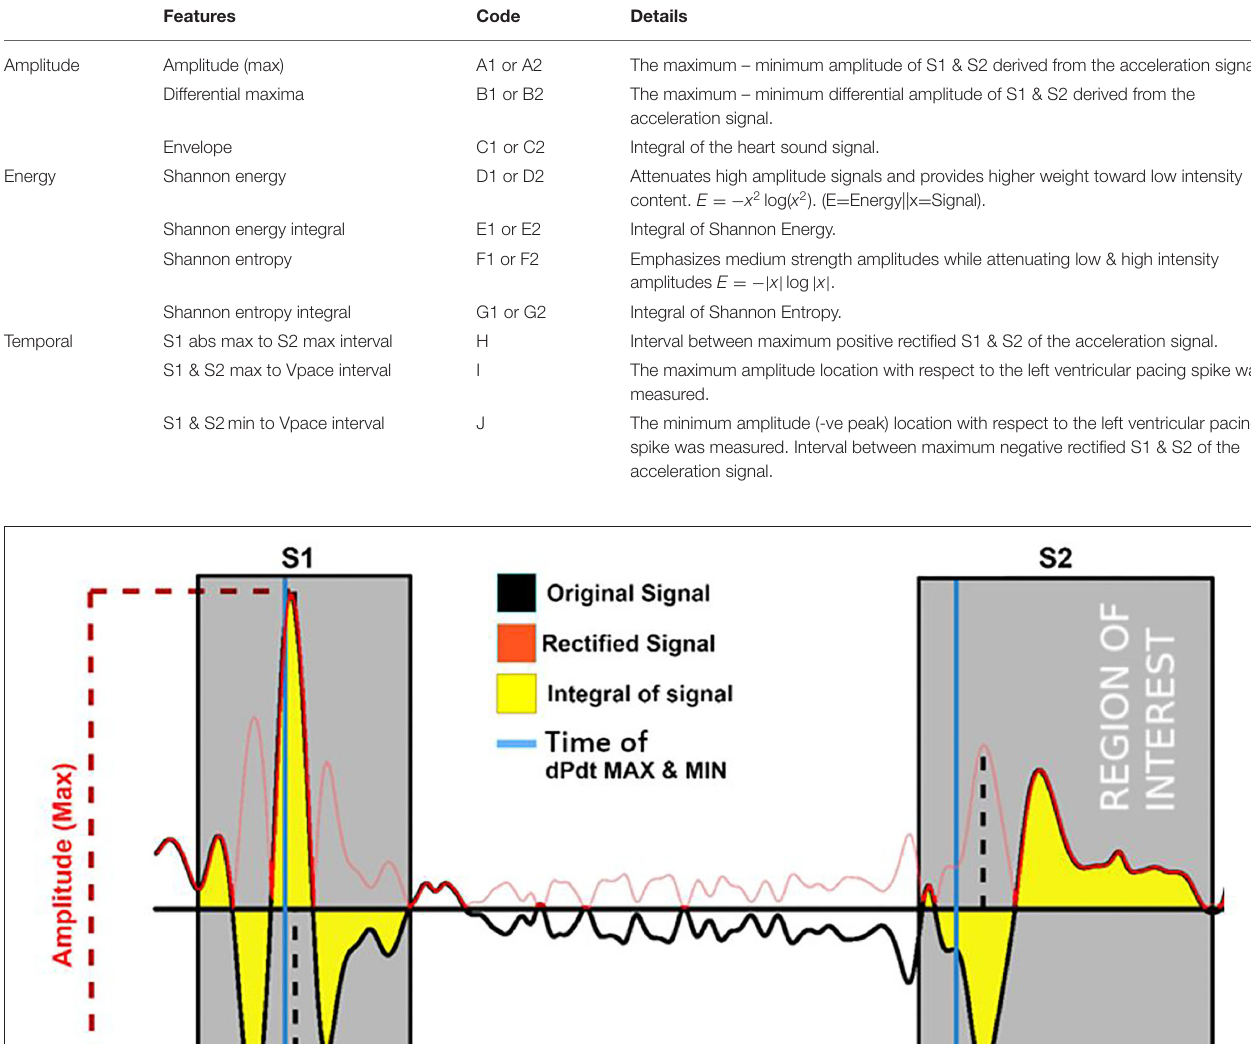
TABLE 1 | Training features that are extracted from regions of interest ( Figure 3 ) located around S1 & S2 of the acceleration and ECG signals.